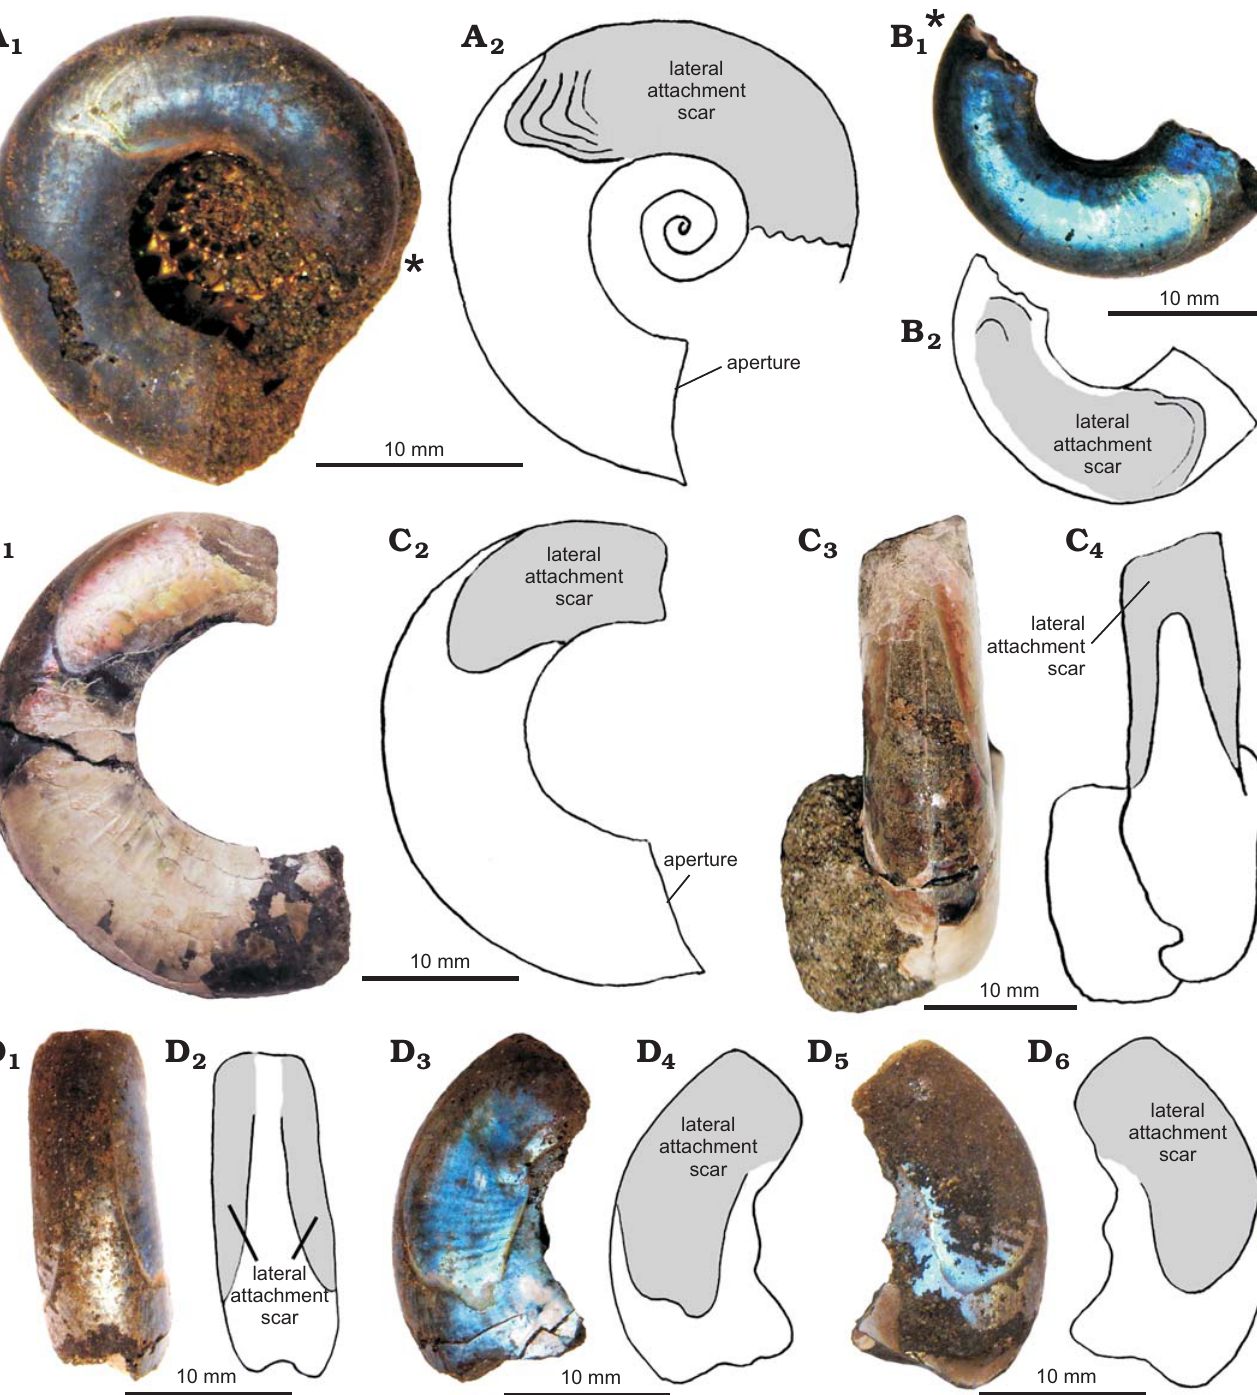
Fig. 4. Lateral attachment scars on Kachpurites fulgens (Trautschold, 1861) shells from Late Volgian ( Kachpurites fulgens Zone), Moscow region, Eganovo locality (A, B), and Mnevniki locality (C, D). A . MSU 113/30, shell with scars, showing several growth lines on the anterior part of the scar. The body chamber is fully preserved. Scars have a thin black anterior border (A two growth lines on the anterior part of the scar. C . MSU 113/46, fragment of the body chamber with preserved outer shell layers; in lateral (C ventral (C , C ) views. D . MSU 113/9, fragment of the body chamber with well-preserved scars on both sides of the shell; in ventral (D 3 4 (D –D ) views. Asterisks mark the base of the body chamber. Photographs (A 3 6 portion. In the central part of the attachment scars, growth lines are very rare. The left and right lateral attachment scars are fused together in some Kachpurites shells on the ventral